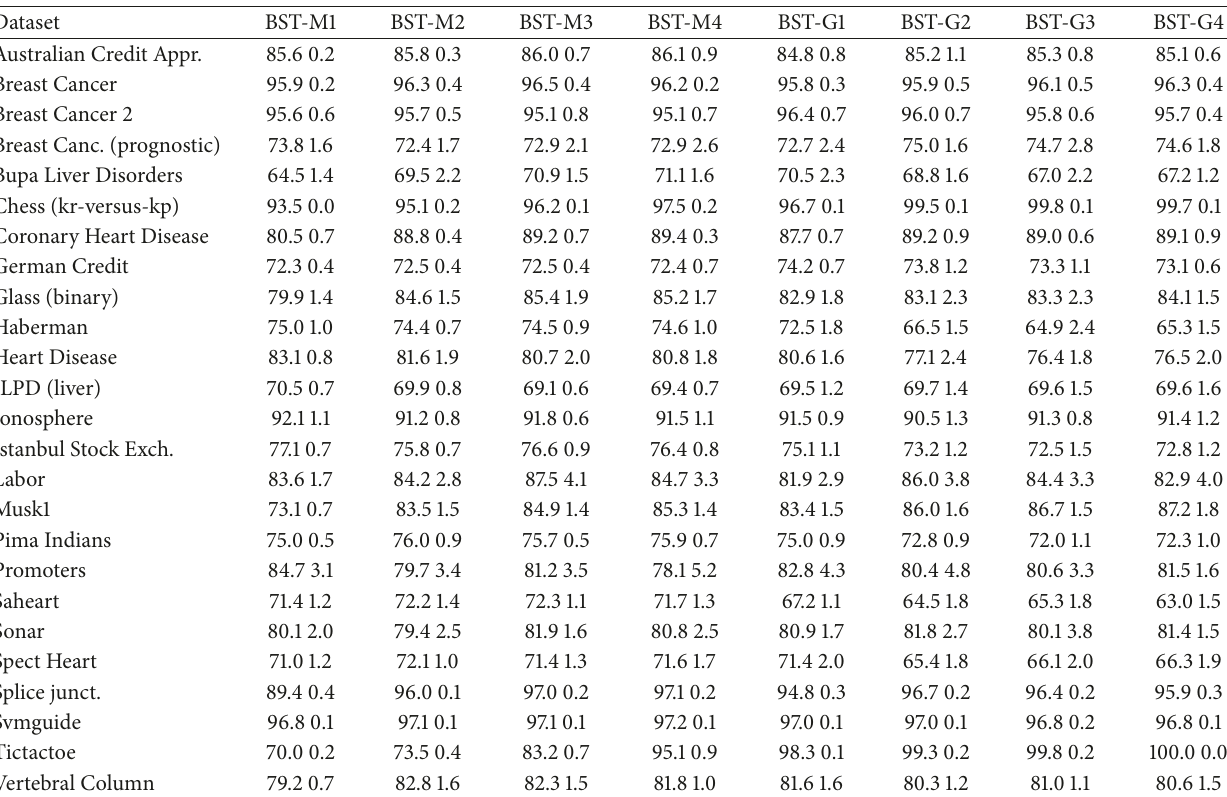
Table 4: Average predictive accuracy and standard deviations of the extracted rules for boosted shallow trees trained by modest boosting and gentle boosting.